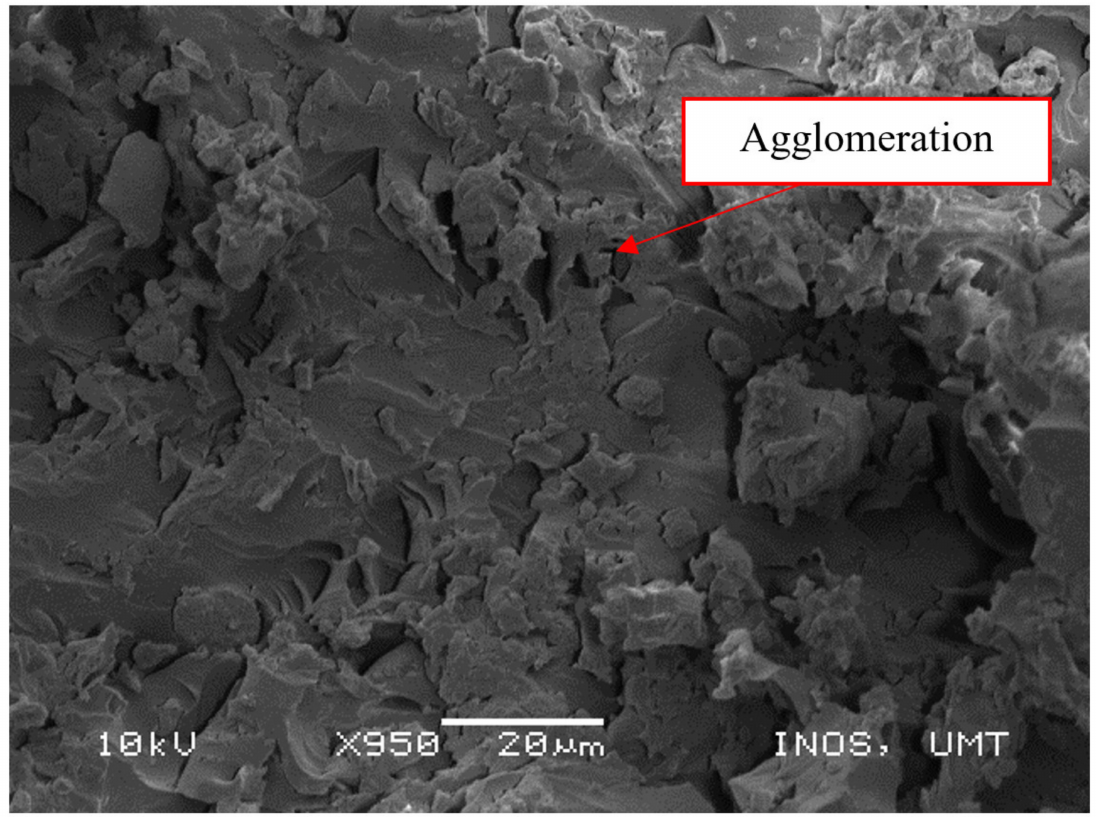
Figure 9. Agglomeration of Mg(OH) 2 in the epoxy/Mg/PET